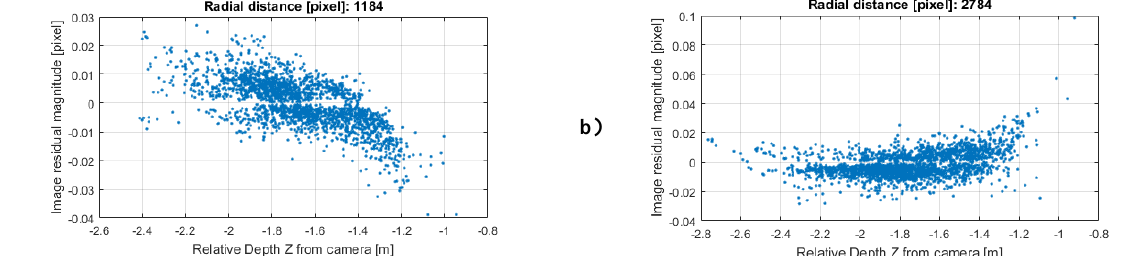
Figure 7. Radial component of image residuals versus relative depth for a cell grid of 64x64 pixels at radial distances respectively of 1184 pixels (a) and 2784 pixels